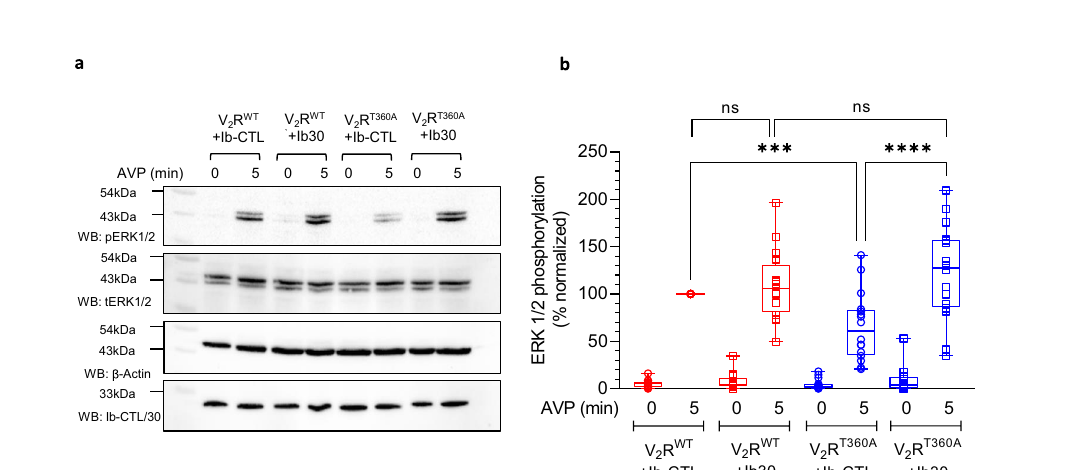
Fig. 7 | Ib30 potentiates agonist-induced ERK1/2 activation for the V 2 R T360A mutant.a HEK-293cellsexpressingtheindicatedreceptorconstructtogetherwith Ib-CTL/Ib30 were stimulated with AVP (100nM) followed by detection of ERK1/2 phosphorylation using western blot. The expression of Ib-CTL/Ib30 is monitored using anti-HA antibody. b Densitometry-based quanti fi cation from sixteen inde- pendent experiments, normalized with respect to V 2 R WT +Ib-CTL condition